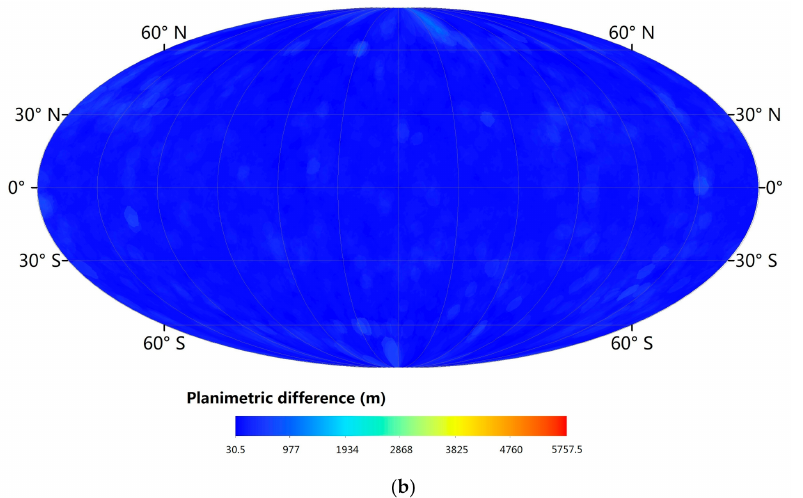
Figure 7. Color-coded map of planimetric difference at a 1 ◦ grid space between ( a ) Clementine UVVIS Warped Color Ratio Mosaic 200 m and CE1_TMap_GDOM_120m before registration; ( b ) Clementine